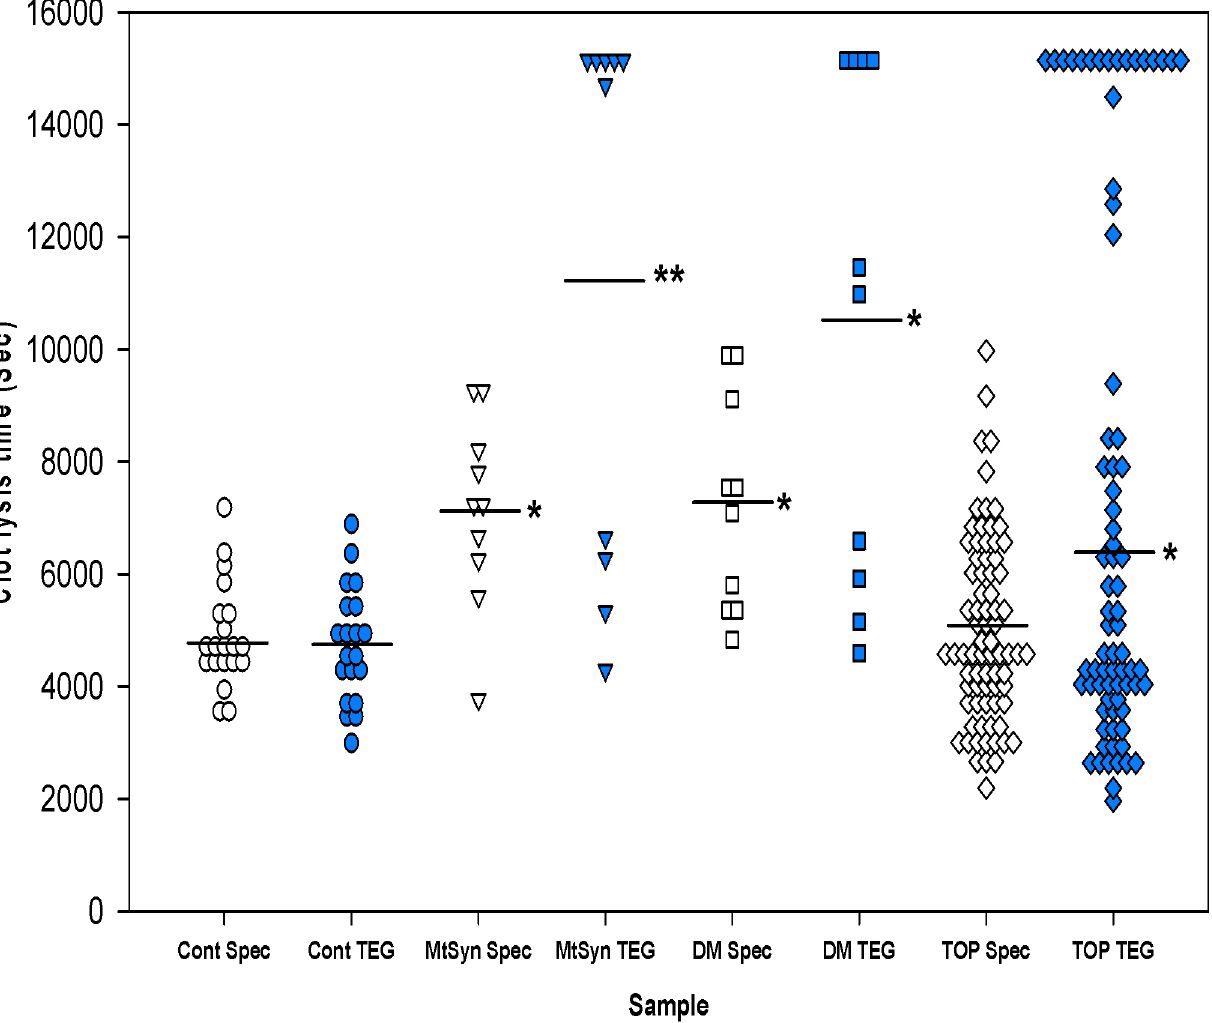
Fig 1. Dot plot of clot lysis time values for each patient. Horizontal lines represent the mean of each group. Abbreviations: Cont-apparently healthy control patients; TEG-thromboelastography; MtSyn- metabolic syndrome; DM-diabetes mellitus; Spec-spectrophotometry (turbidimetric method); TOP-TOPCOAT. * p < 0.05 vs. control, ** p < 0.01 vs. control, ANOVA with Dunnett ’ s